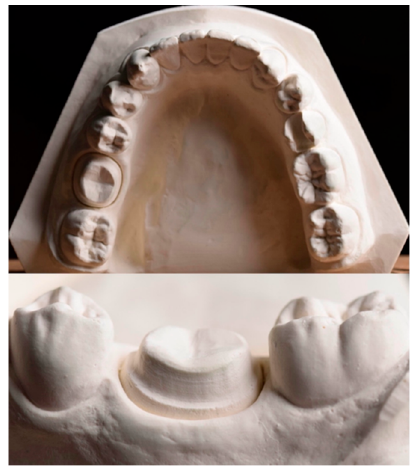
Table 2. Crystallization parameters of the materials used in the present study.